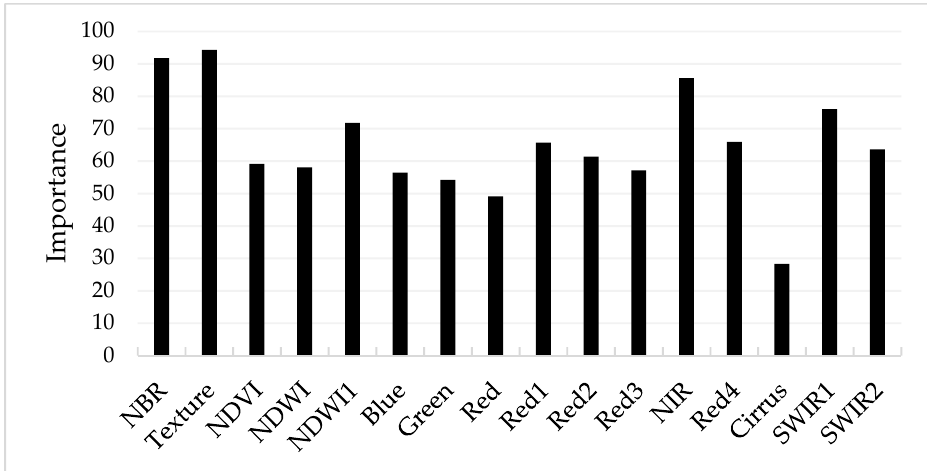
Figure 9. The importance of each variable in burned area mapping.